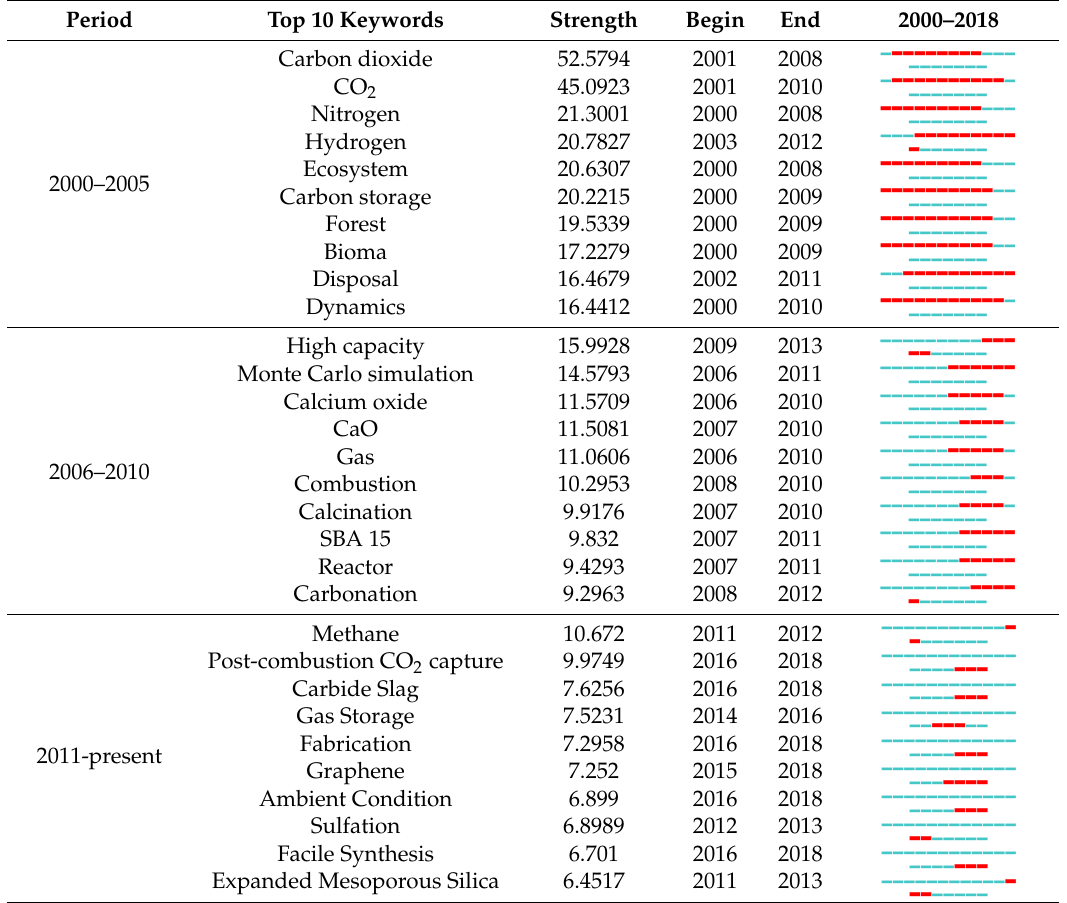
Table 6. Top 10 keywords with strong citation bursts in different periods.